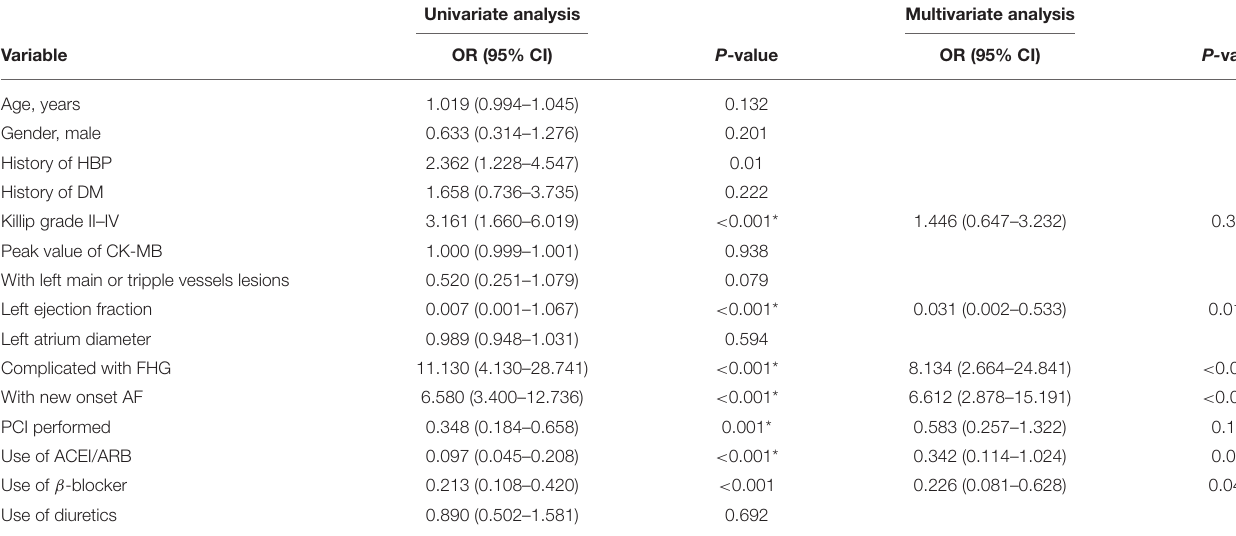
TABLE 4 | Logistic regression analysis for risk factors attributing to in-hospital mortality in the study.